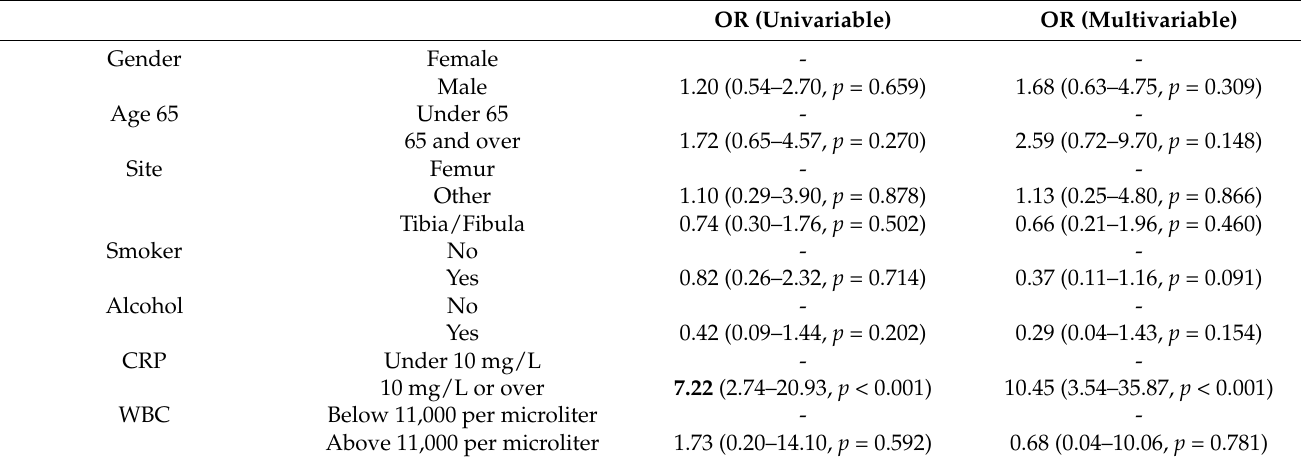
Table 2. Univariate and multivariate analysis of risk factors predicting infection.